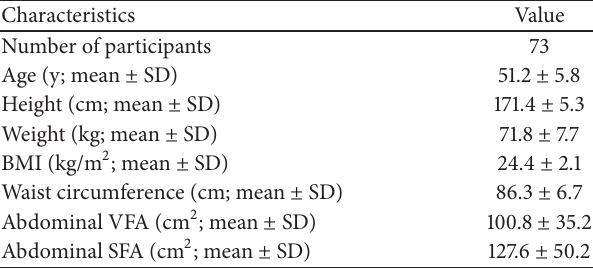
Table 1: General characteristics of